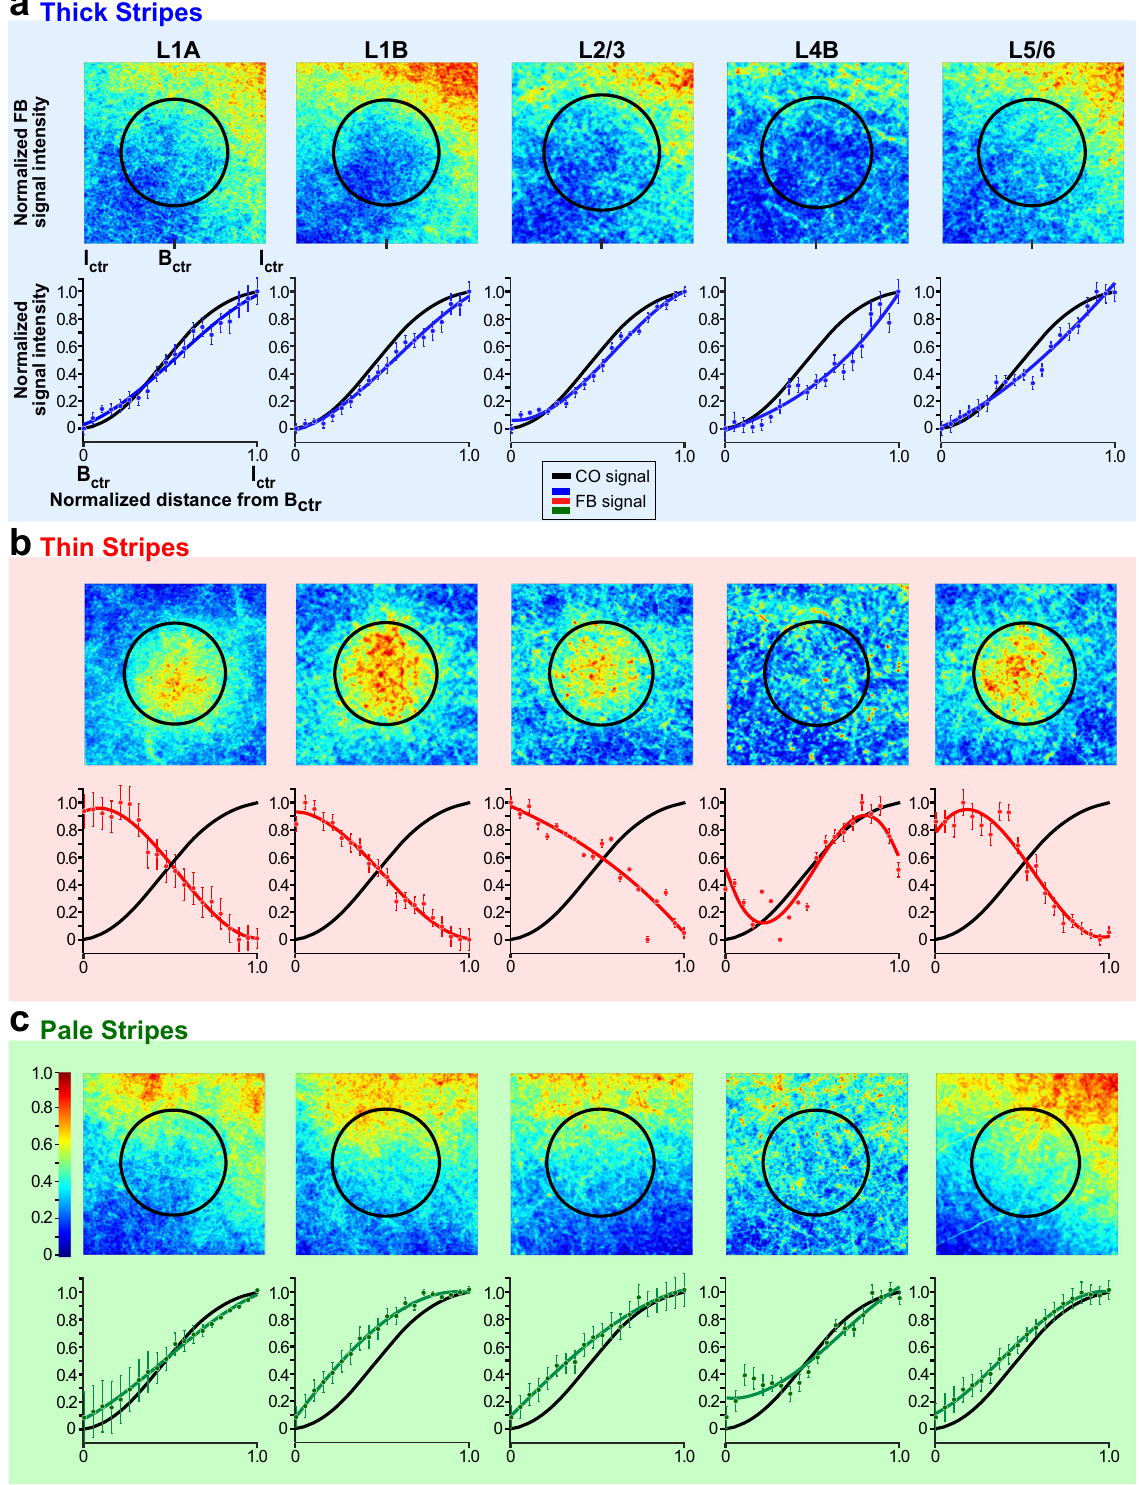
Fig. 7 Population analysis. Mean heatmaps of fl uorescent signal intensity (top panels), and plots of fl uorescent and CO signal intensities (bottom panels) for the population of FB projections arising from a V2 thick stripes ( n = 3), b thin stripes ( n = 3), and c pale stripes ( n = 3). For details of how the population means were computed see “ Methods ” . Error bars in the fl uorescent signal intensity plots are s.e.m. Statistical analysis of differences between stripe types are reported in the “ Results ” . Conventions are as in Fig. 4. Source data for bottom panels in ( a – c ) are provided as a Source data fi